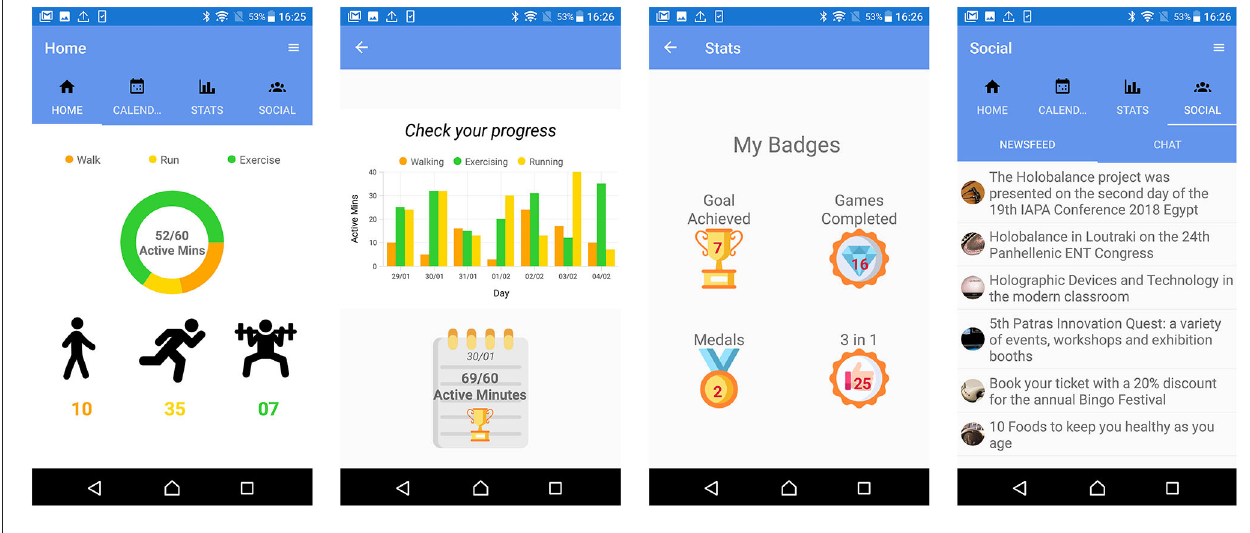
FIGURE 3 | Mock-ups of the Activity Planning Application.